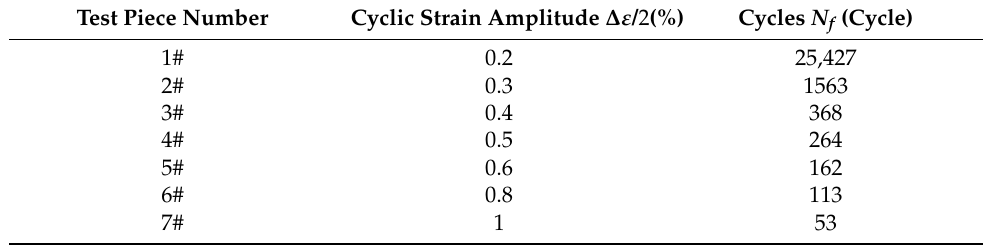
Table 4. The value of the fitted parameters